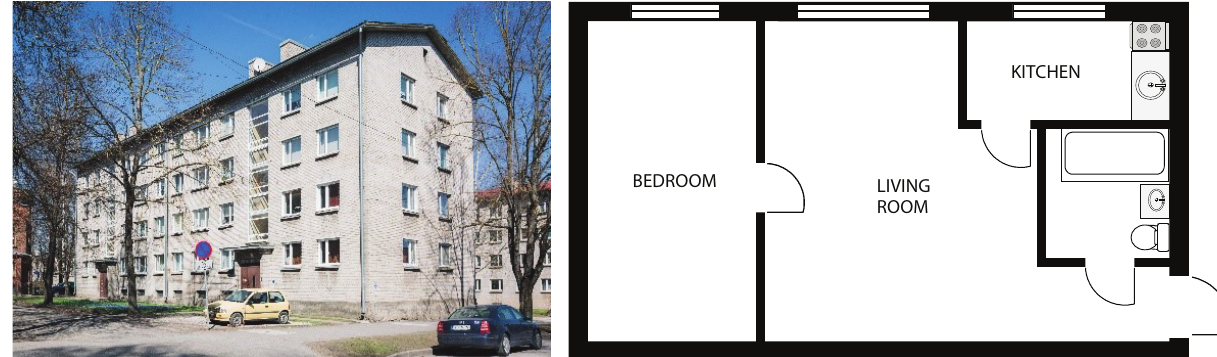
Figure 1. A khrushchyovka‐type apartment building in Tartu (left) and a floor plan of a typical apartment in a khrushchy‐ ovka (right). Source: Photo courtesy of Silver